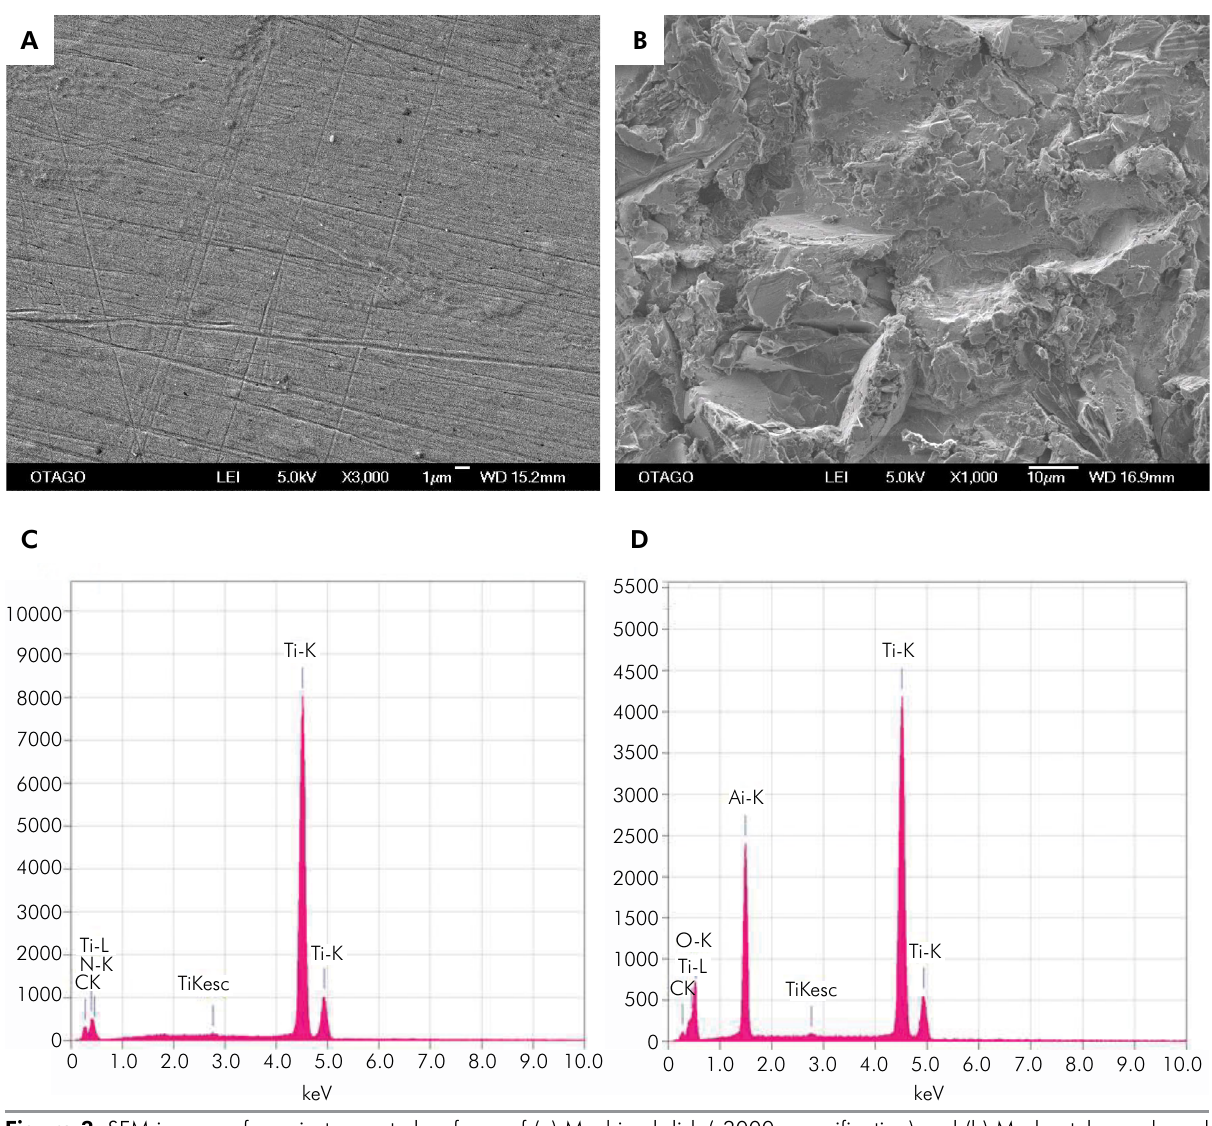
Figure 3. SEM images of non-instrumented surfaces of (a) Machined disk (x3000 magnification) and (b) Moderately roughened (x1000 magnification) surfaces at respectively. EDS profiles of non-instrumented surfaces of (c) machined disk surface. (d) Moderately roughened disks, which show counts of